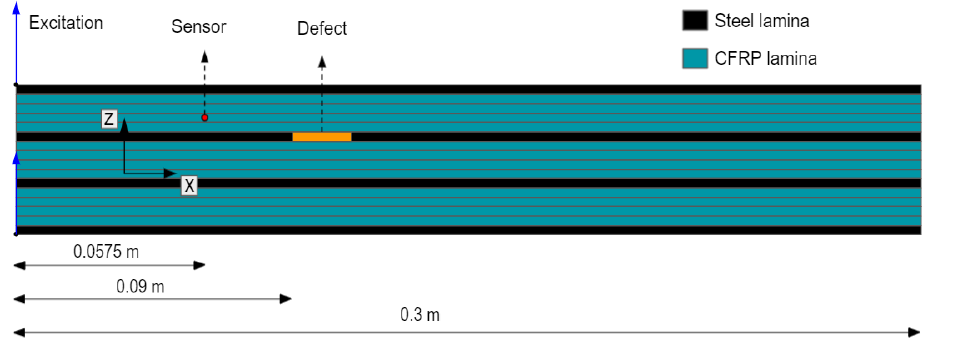
Figure 1. Model setup used for simulation of Lamb wave propagation in carbon fiber reinforced epoxy steel laminate.